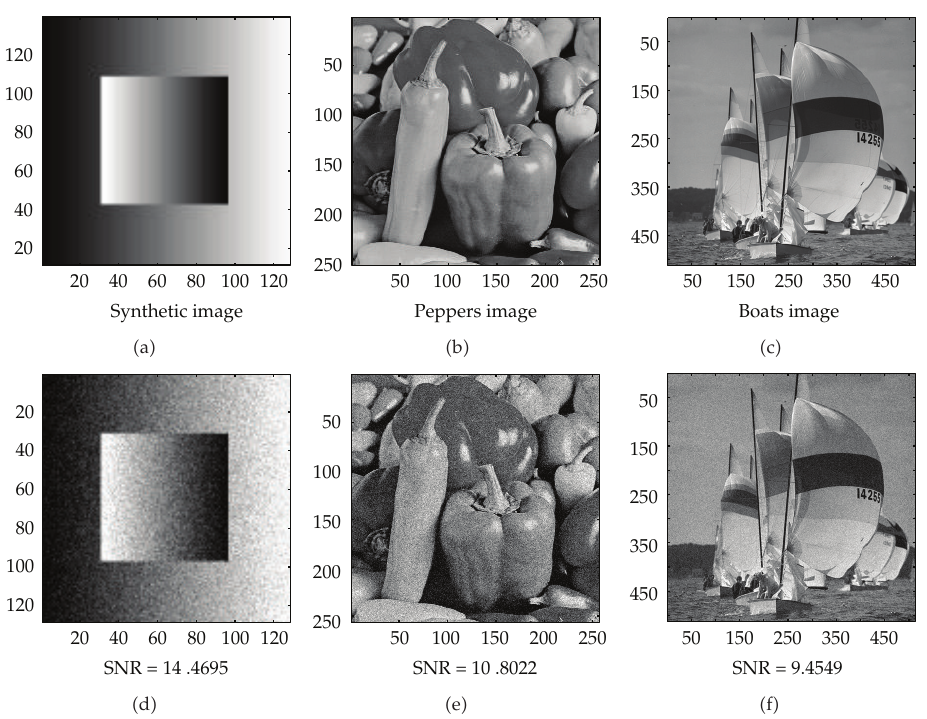
Figure 1: The original images and the noisy images with three di ff erent sizes in Example